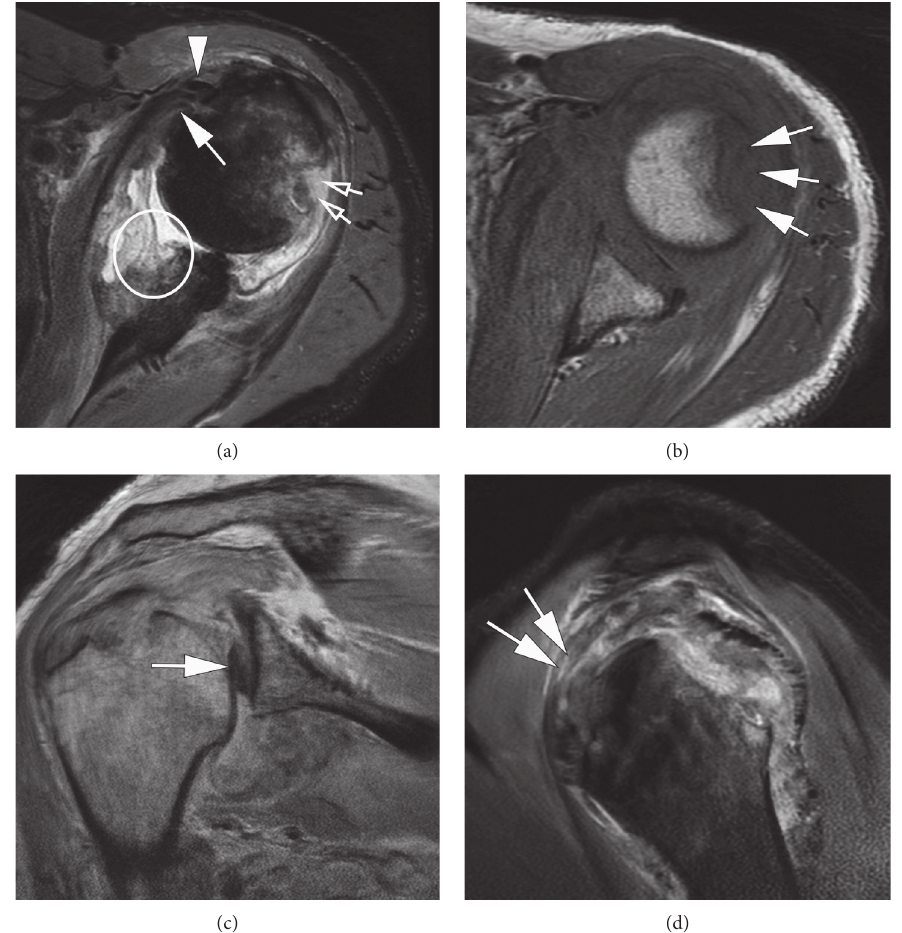
Figure 9: A 67-year-old man with persistent pain after a left shoulder dislocation. Axial T2-weighed FS MRI (a) shows a partial articular surface tear of the subscapularis tendon (large arrow) with mild medial displacement of the long head of the biceps tendon (arrowhead). Also evident are an osseous Bankart lesion (ellipse) and the corresponding Hill–Sachs deformity (two short arrows). The full extent of the Hill–Sachs depression is best appreciated in the axial PD-weighted MRI (b), consistent with recent anterior dislocation. Coronal PD-weighted MRI (c) demonstrates a superior labral tear with the displacement of a portion of labrum (arrow) into the glenohumeral joint space. Sagittal oblique T2-weighed FS MRI (d) shows an intrasubstance tear of the genu of the long head of the biceps